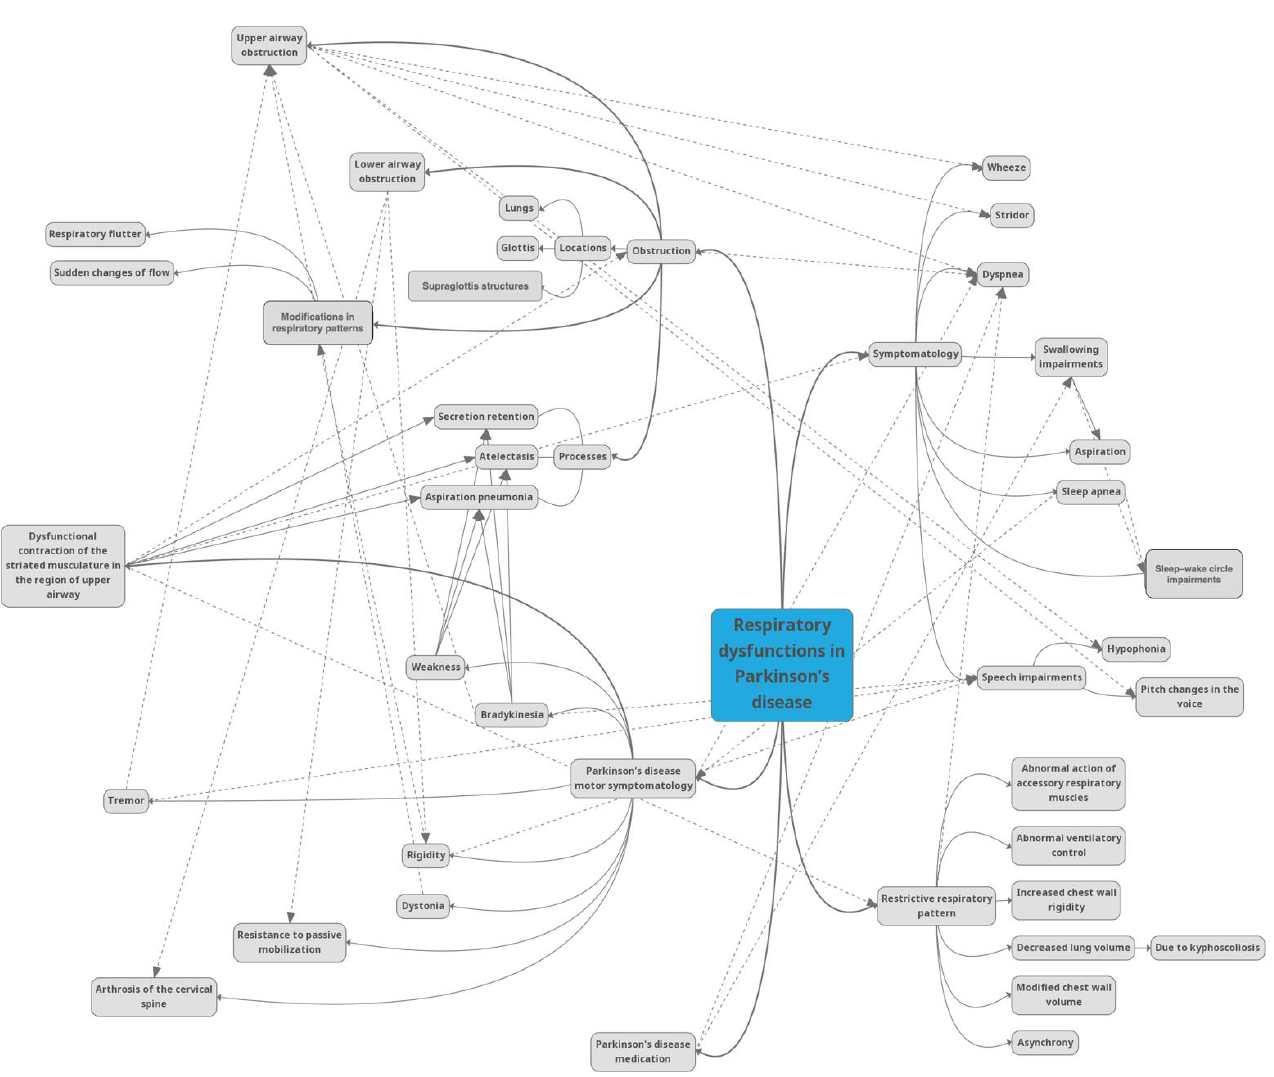
Figure 1. The most significant characteristics in Parkinson’s disease respiratory impairments and the relationships be- tween them.